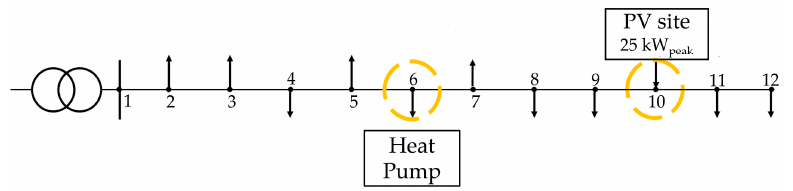
Figure 6. Test Case: 12-bus low voltage grid.